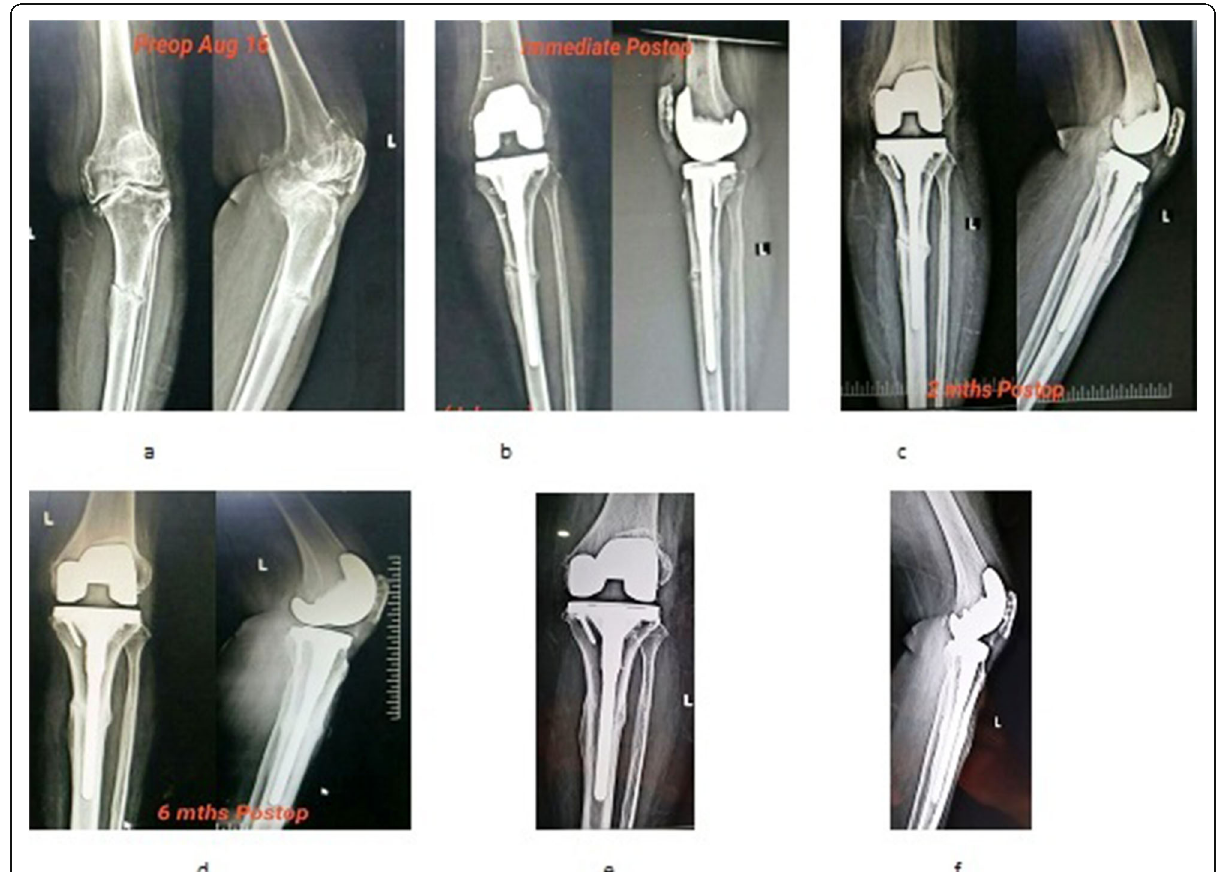
Fig. 5 Left Knee X-rays (Delayed fracture healing) a ) Preoperative anteroposterior and lateral view showing features suggestive of osteoarthritis, with deformity with stress fracture proximal tibia; b ) Post operative X-ray anteroposterior and lateral view showing correction of deformity with modular stemmed knee prosthesis with intact fibula; c ) 8 week follow-up anteroposterior and lateral view showing healing of fracture in process with correction of deformity with modular stemmed knee prosthesis with intact fibula; d ) 24 week follow-up anteroposterior and lateral view showing healed stress fracture with correction of deformity with modular stemmed knee prosthesis with intact fibula; e ) and f ) Recent follow-up anteroposterior and lateral view showing healed stress fracture with correction of deformity with modular stemmed knee prosthesis in situ